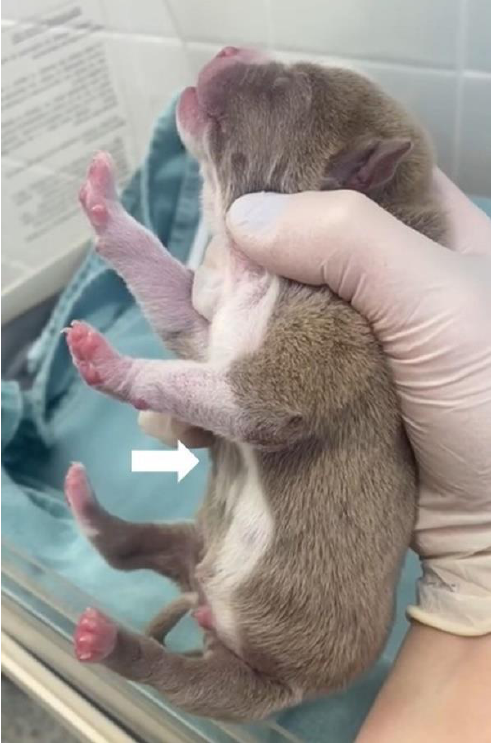
standards for age. The chest X-ray (Figure 11) was performed in the right lateral and ven- trodorsal positions, observing a ventrodorsal deviation of the sternum and diagnosing pectus excavatum. The frontosagittal and vertebral indices corresponded to 1.7 cm (≤2 cm) and 10 cm (>9 cm), respectively, classifying the pectus as mild grade. In addition, a Figure 10. Ventrodorsal narrowing in the sternal region (arrow). rounded cardiac silhouette (globose aspect) and right cardiac deviation were observed. Figure 10. Ventrodorsal narrowing in the sternal region (arrow). Complementary tests, hemogram and chest X-ray, were performed. Blood (0.4 mL) from the jugular vein was collected for the hemogram, which was within the reference